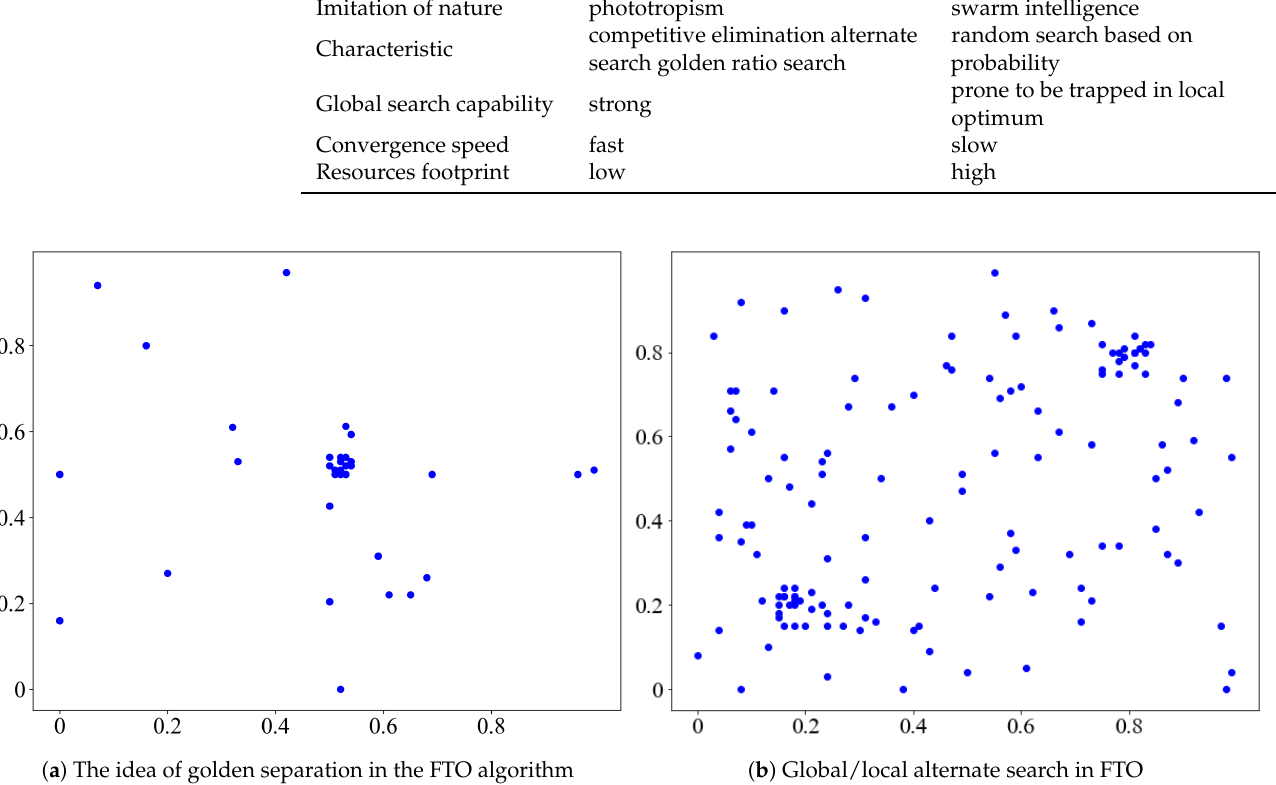
( a ) The idea of golden separation in the FTO algorithm structure Figure 6. Optimal points in each iteration of FTO for optimizing: ( a ) f ( x , y ) = ( b ) f ( x , y ) = 0.5 ( sin ( 10ln ( x )) + sin ( 10ln ( y ))) , x , y ∈ [ 0,1 ]